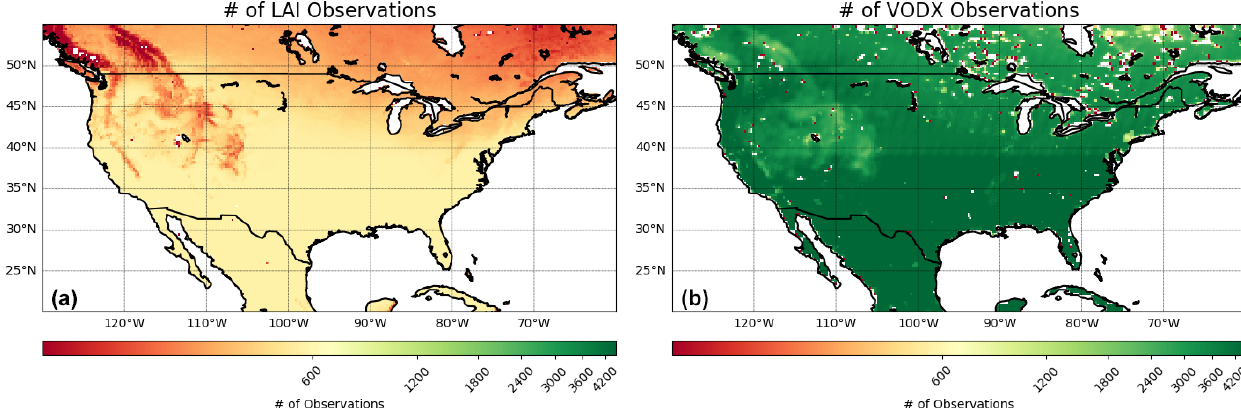
Figure 1. Maps showing the cumulative number of observations provided for (a) CGLS LAI and (b) VODCA VODX over CONUS between 2003 and 2018. The color bar is on a log scale in order to show the vast differences between the two datasets.